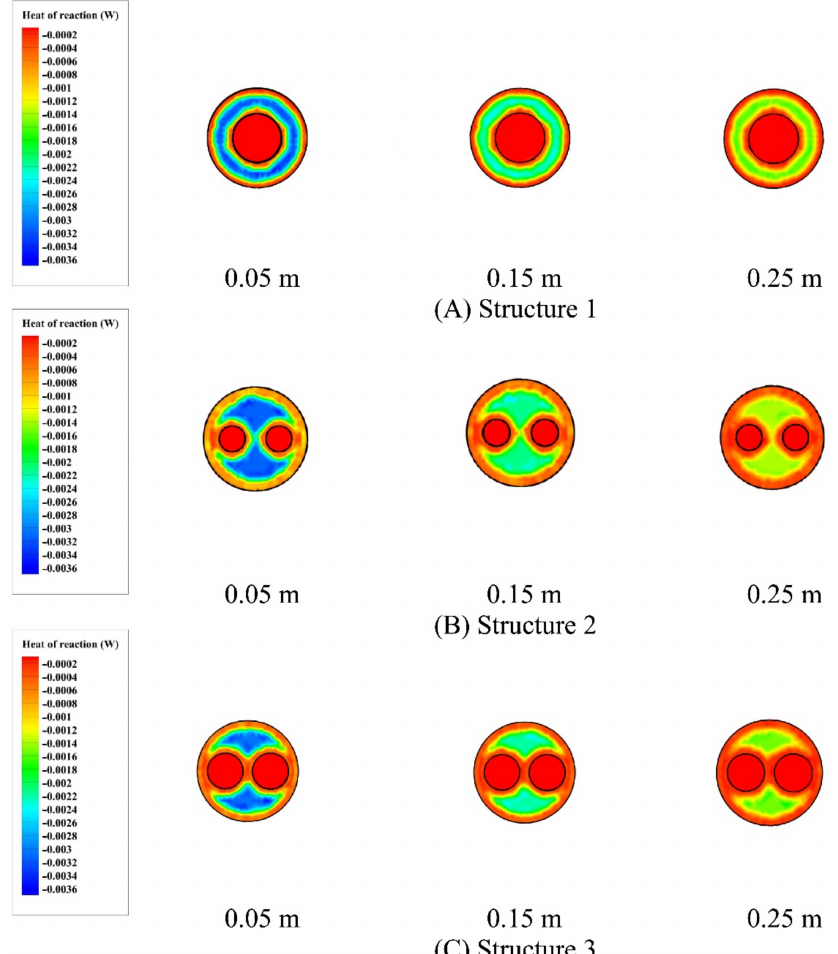
Figure 11. Reaction heat production distribution in the bayonet heat exchanger for an inlet flow rate of 0.00035 kg/s. ( A ) Structure 1, ( B ) Structure 2, ( C ) Structure